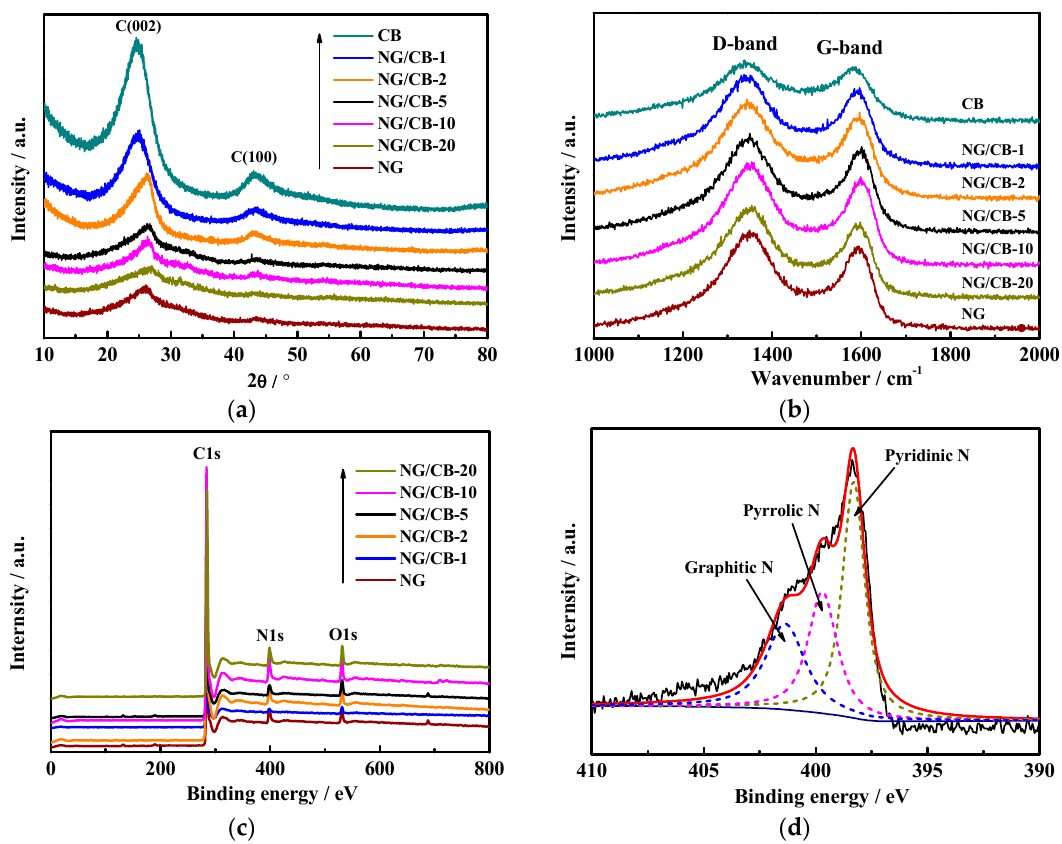
Figure 5. XRD ( a ), Raman ( b ) spectra and XPS survey ( c ) of NG/CB-x electrocatalysts, and high resolution of N1s of NG/CB-10 ( d ).